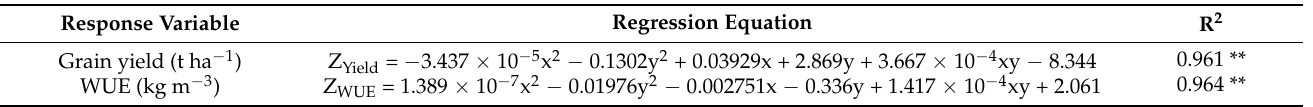
Table 4. Regression equations for the response variables of grain yield and water use efficiency (WUE) of maize under different irrigation and planting density